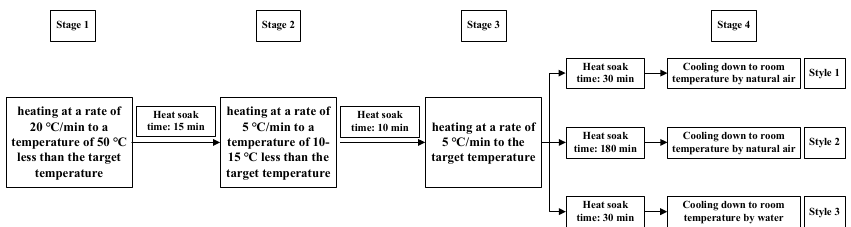
Figure 2. Heating–cooling treatment process.